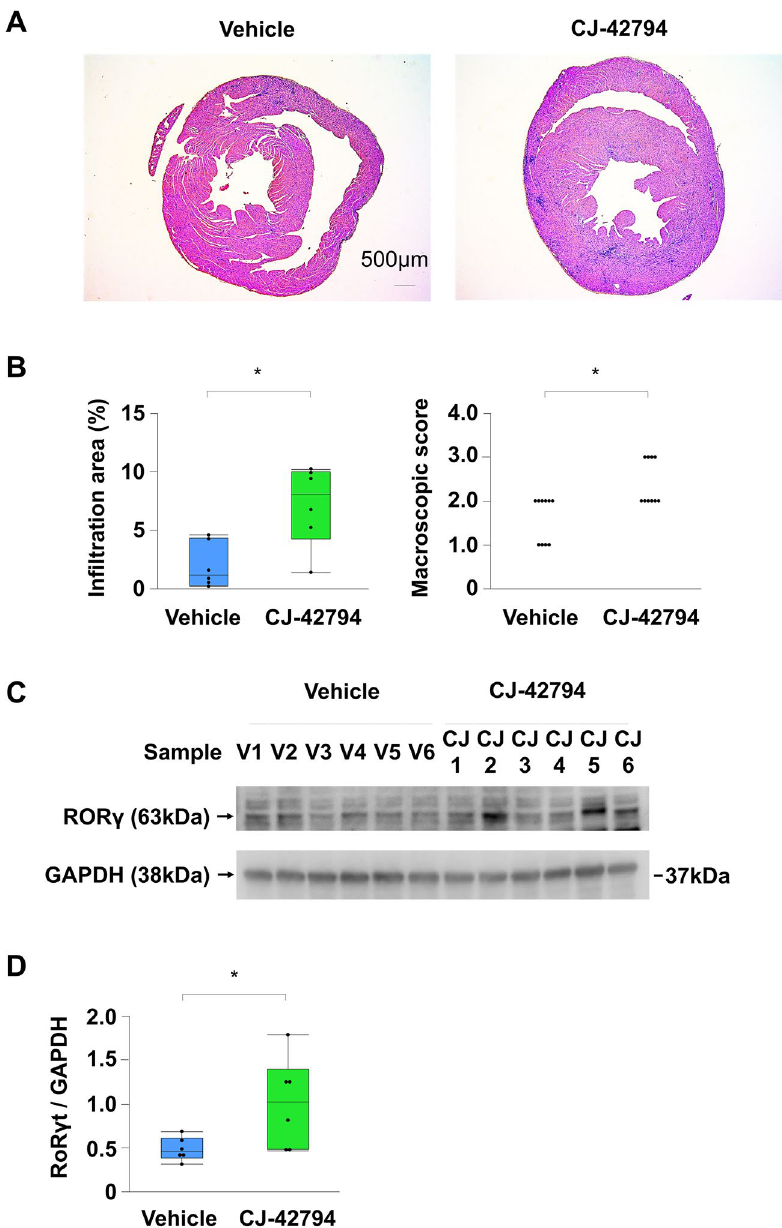
Figure 1. Myocardial inflammation in the experimental autoimmune myocarditis (EAM). ( A ) Representative Hematoxylin–Eosin staining and ( B ) statistical analyses of inflamed area (n = 6/each) and macroscopic score (n = 10/each) in ventricular cross-sections and hearts, respectively on day 21 obtained from EAM treated daily with vehicle or selective prostaglandin E2 receptor 4 (EP4) antagonist (CJ-42794) from day 14 to day 21. Scale bars: 500 μm. Inflamed area was calculated by affected area/ventricular area × 100%. ( C ) Western blot (cropped gel) and ( D ) its densitometric analysis (n = 6/each) of the EAM inducible Th17-specific master transcription factor, retinoic acid receptor-related orphan nuclear receptor (ROR γt) on day 21 hearts from EAM mice treated with vehicle or CJ-42794. Full-length blots of ROR γt and GAPDH are presented in Supplementary Fig. 4A. * P < 0.05 (vs. vehicle) calculated with nonparametric 2-tailed Mann–Whitney U